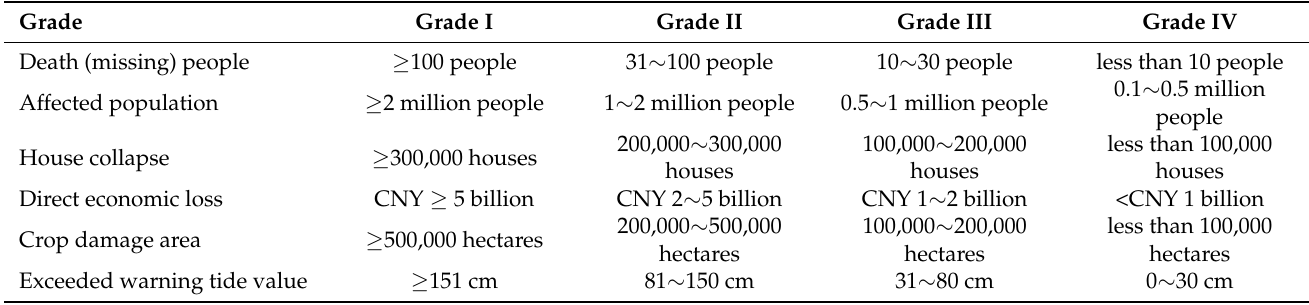
Table 2. Criteria for disaster-forming attribute grades in case